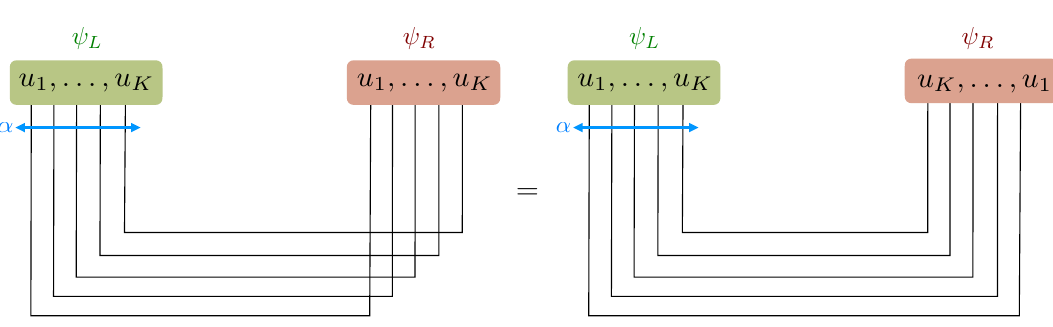
Figure 4. Matrix part for (cid:22) (cid:11) = ? : one can simply act the S-matrix to the right wave function R and simplify the structure. Note we are using the normalization of the matrix part, in which the abelian part ( sl (2) S -matrix) is